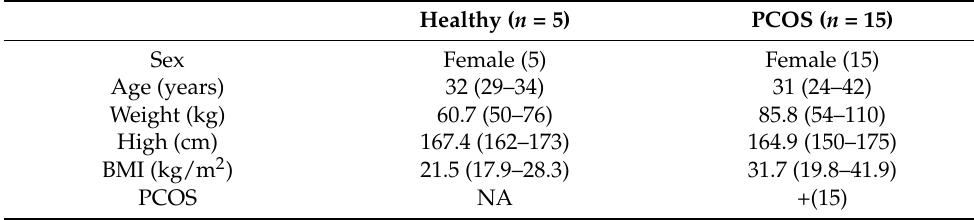
Table 1. Demographical data of the study